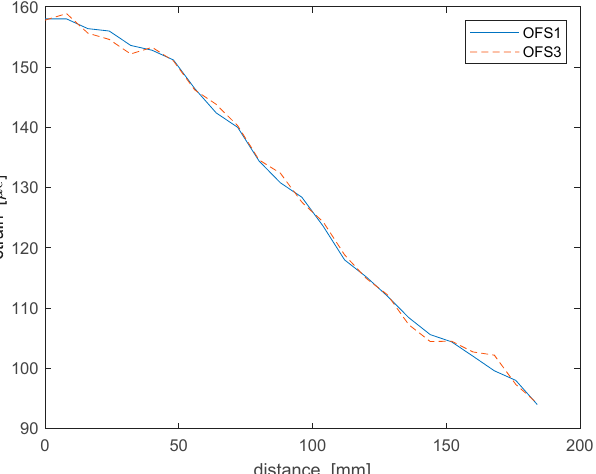
Figure 7. Distributed strain measurement along the optical fiber strands OFS1 and OFS3 with the plate in the cantilevered state.